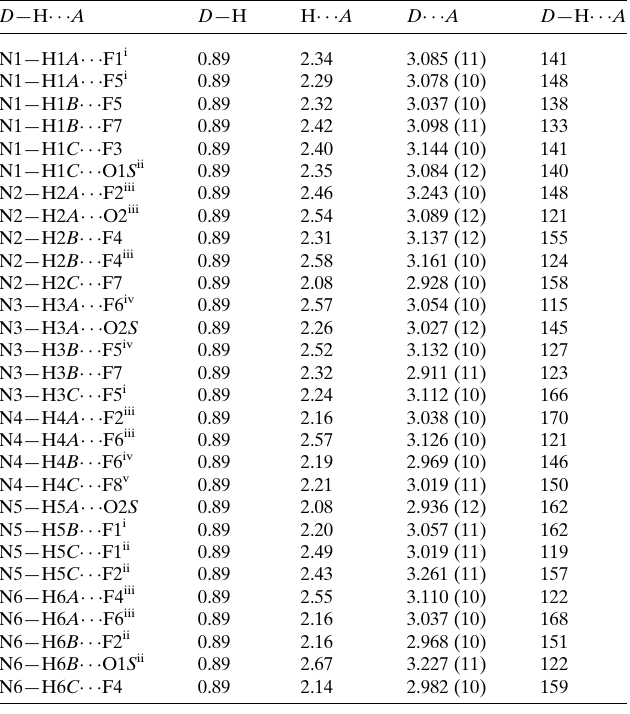
Table 1 Hydrogen-bond geometry (A˚ , (cid:4) ).